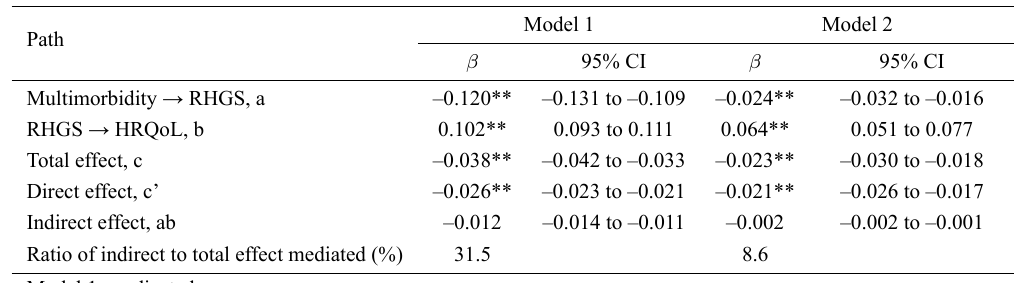
Table 4. A mediating analysis of relative handgrip strength for the relationship between multimorbidity and health-related quality of